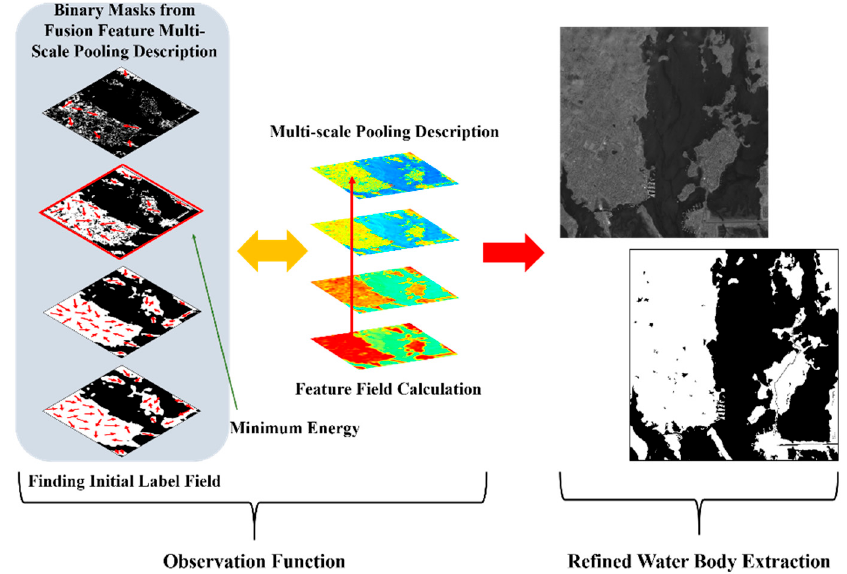
Figure 8. The proposed label field initialization with Markov modeling for refined water body